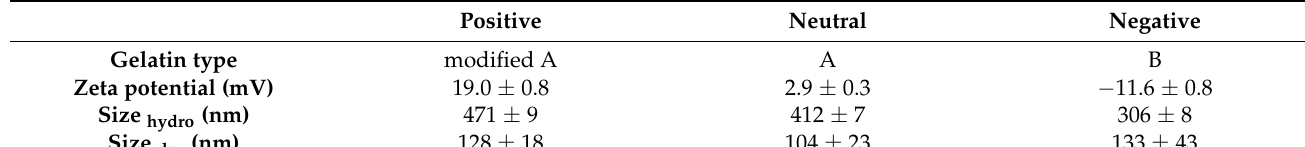
Table 1. Characteristics of bare gelatin nanoparticles.